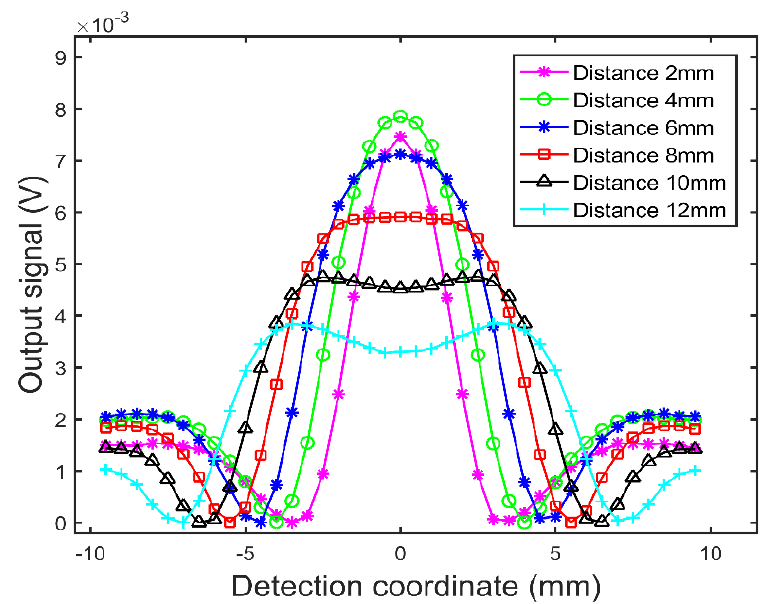
Figure 6. The simulation testing of vertical crack defect using the probe with different excitation coil distance.